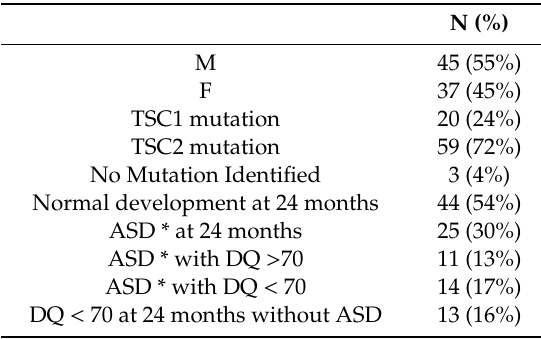
Table 1. Demographic and neurodevelopmental data, genetic status, and diagnostic classification at the final follow-up (two years of age) of the 82 infants with Tuberous Sclerosis Complex (TSC).